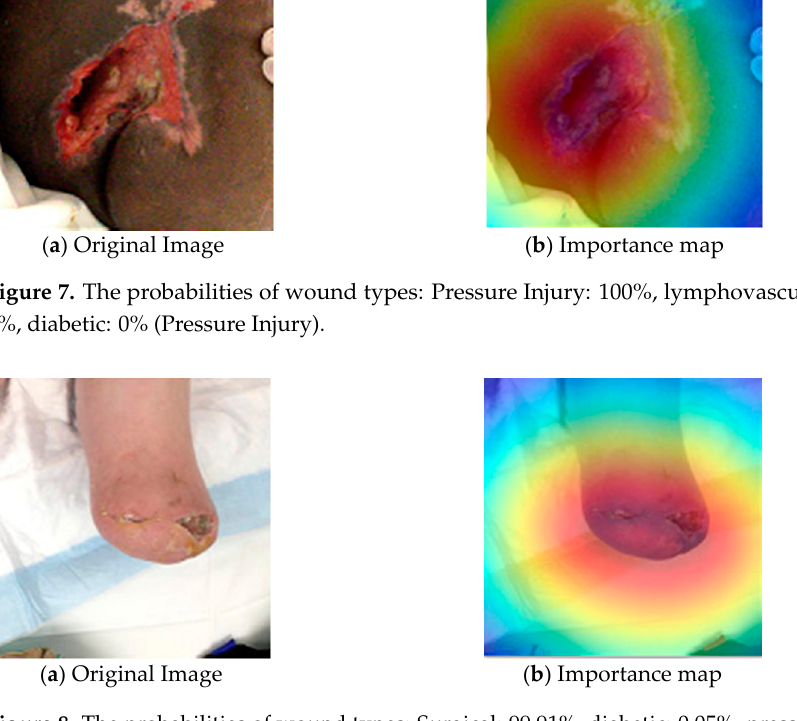
Figure 8. The probabilities of wound types: Surgical: 99.91%, diabetic: 0.05%, pressure injury: 0.03%, lymphovascular: 0.01% (Surgical).